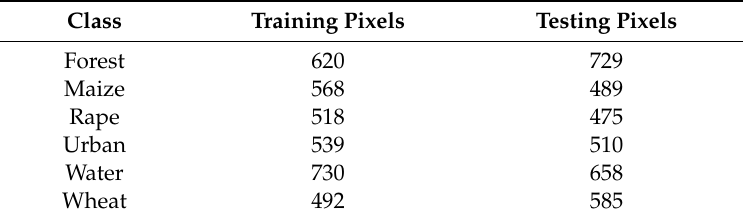
Table 3. Distribution of training and verification pixels for land-cover